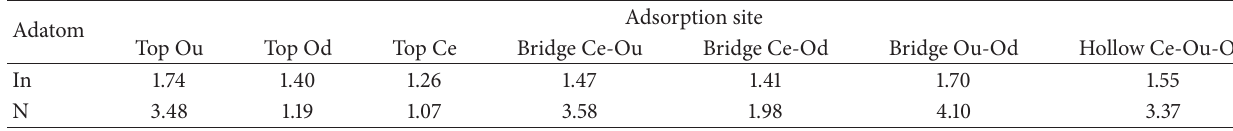
Adsorption site